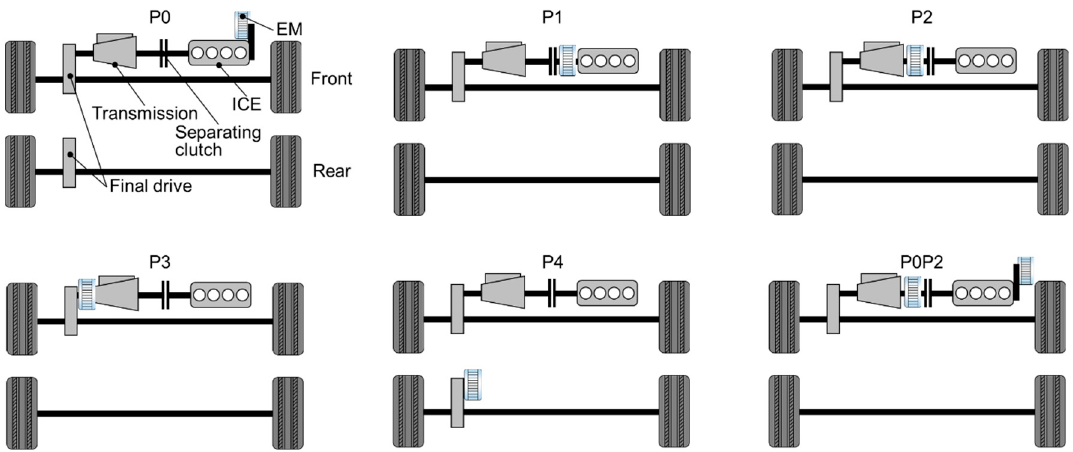
Figure 1. Arrangements of the EM (electric machine) in basic parallel hybrid topologies (P0-P4) and exemplary arrangement through combination (P0P2).